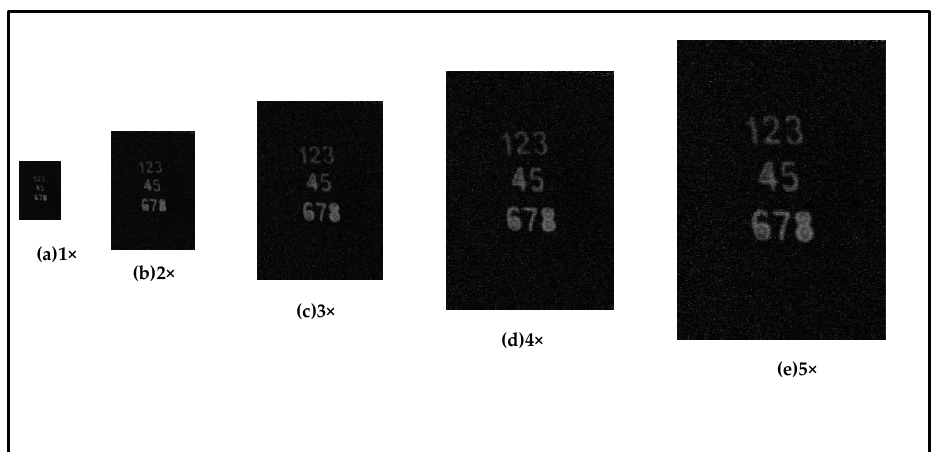
Figure 10. Reconstructed DOP images at various magnifications. Figure 11a. As the magnification factor increases, the entropy value reaches its peak, indicating that the spatial correlation between the pixels is weakest at this spatial scale. These may be the optimal scales at the selected distance.